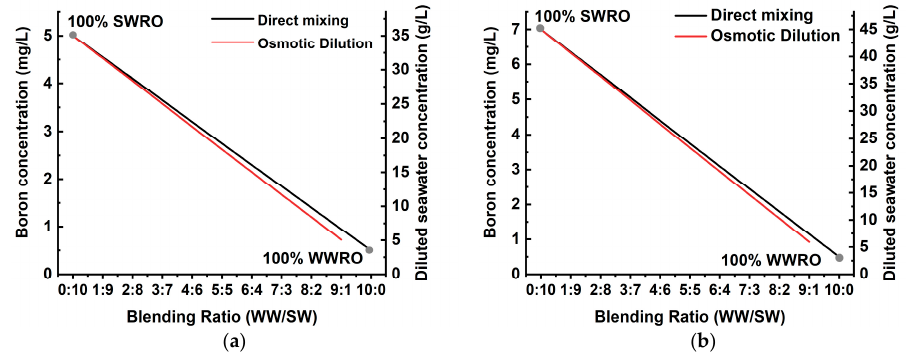
Figure 1. Variation of boron concentration coupled with TDS concentration of seawater by blending ratio of treated wastewater and seawater in ( a ) Arabian Gulf and ( b ) the average of seawater concentration.